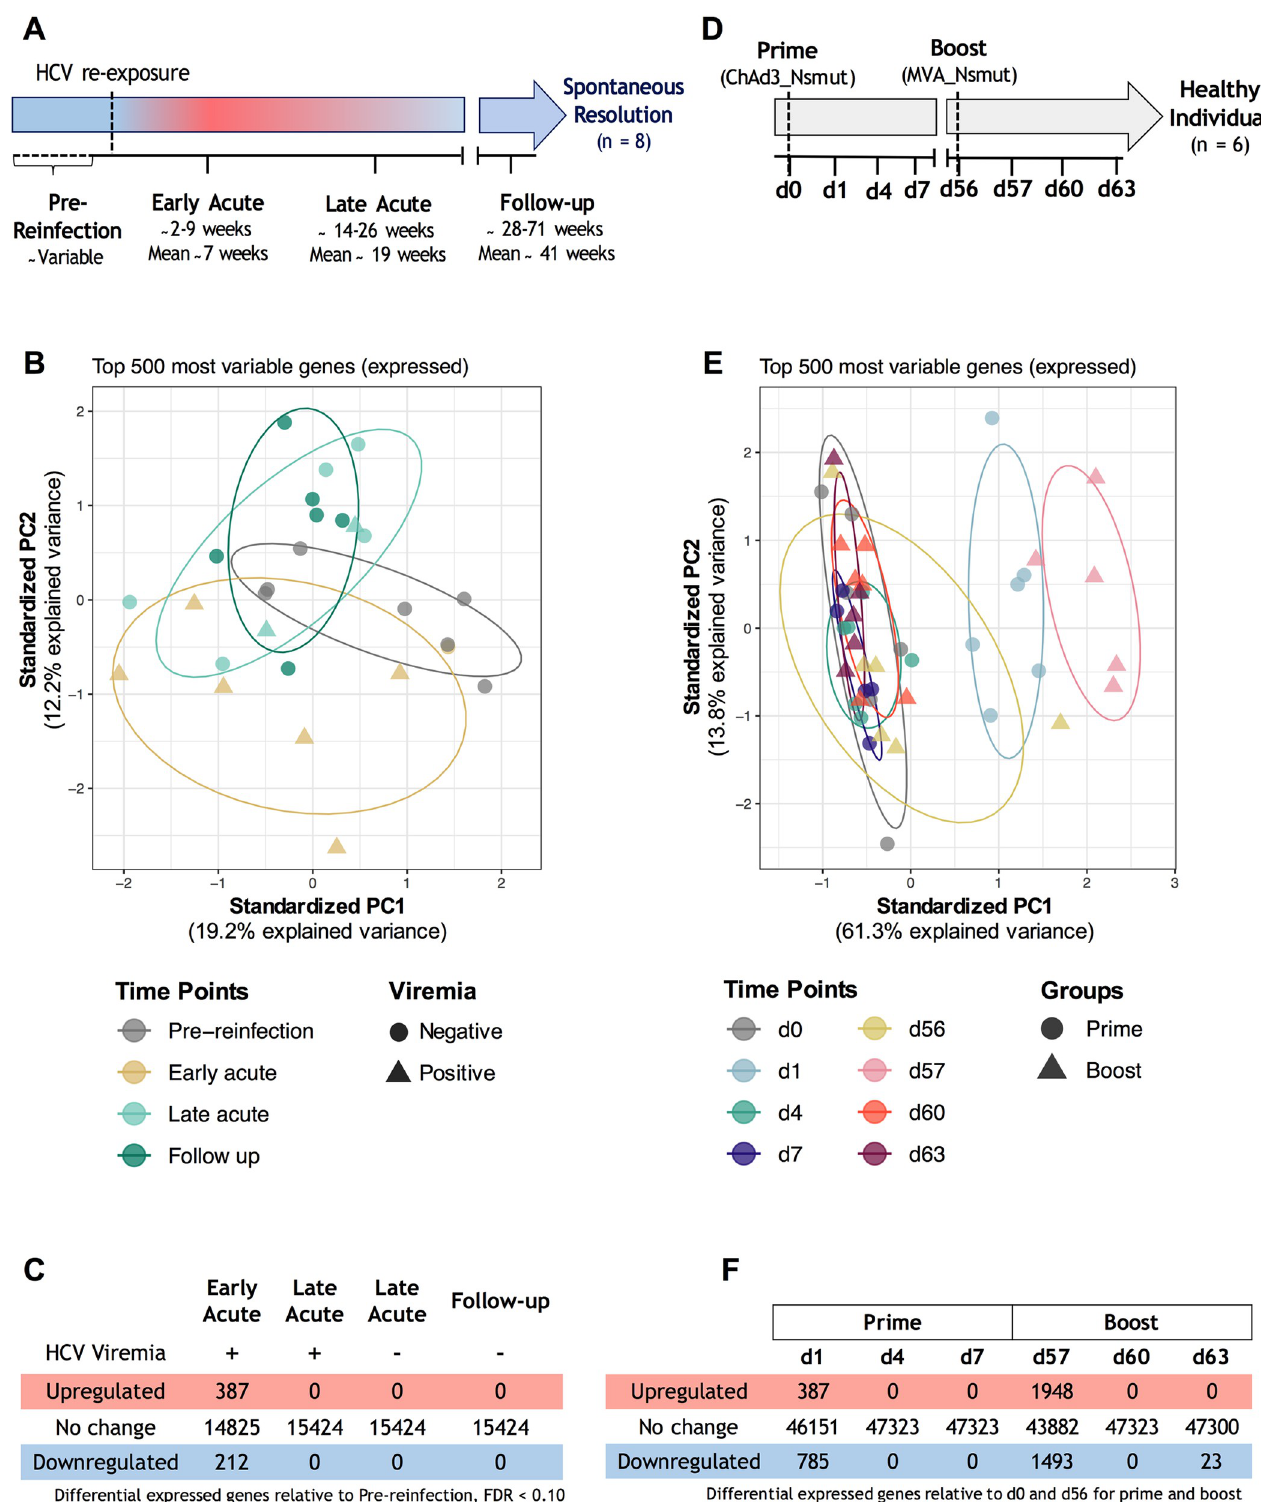
Fig 1. Study design and differential gene expression analysis. (A) Reinfection study design. (B) Principal component analysis (PCA) of the top 500 genes expressed in the reinfection group. As described in Materials and Methods, patient-specific gene expression variation was removed using the function